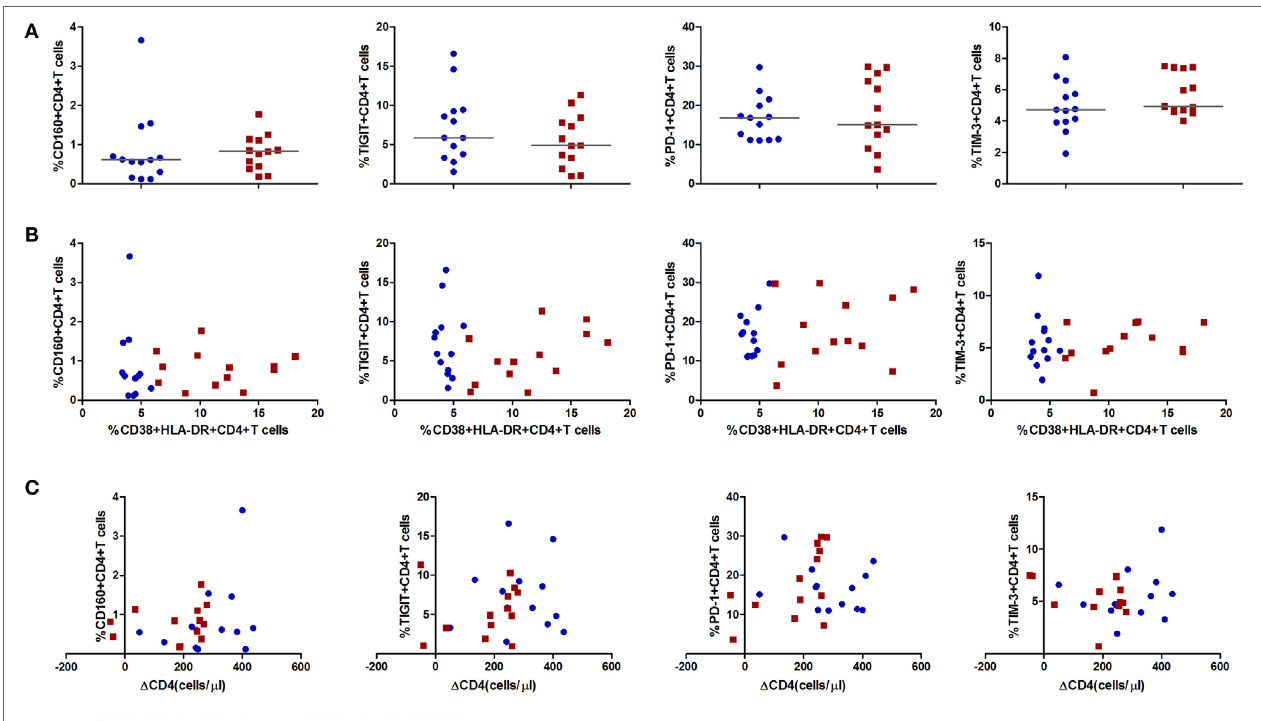
FigUre 4 | Expression of inhibitory molecules on CD4 + T cells in acute HIV-1 infection stage and their correlations with the level of CD4 + T cell activation and CD4 + T cell depletion. (a) Comparisons of the expression level of inhibitory molecules CD160, T cell immunoglobulin and ITIM domain, programmed cell death protein 1, and T cell immunoglobulin and mucin 3 on CD4 + T cell activation high ( ■ ) and low ( ● ) groups in acutely infected patients. Correlation analysis between inhibitory molecules and the level of CD4 + T cell activation (b) and Δ CD4 (c) . Significance of difference was calculated by Mann–Whitney U test. Correlation analysis was performed by Spearman’s rank test. Horizontal lines indicate median